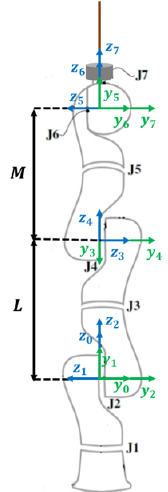
Figure 1. Kinematic structure of KUKA LWR4+ robot. The robot is in its home position [ 0,0,0,0,0,0,0 ] with a force sensor mounted between the end effector and the surgical tool. Table 1. Denavit–Hartenberg (D-H) parameters of KUKA LWR4+ robot.